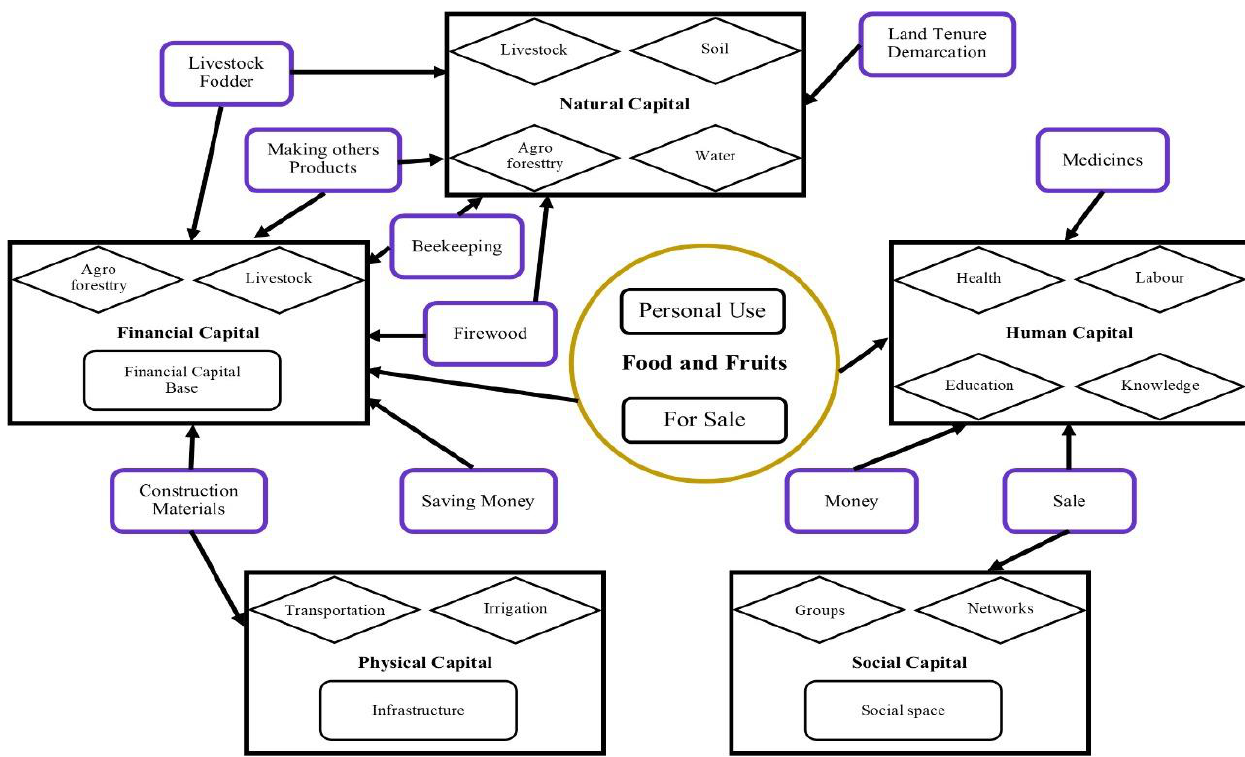
Figure 3. Agroforestry benefits and sustainable livelihood